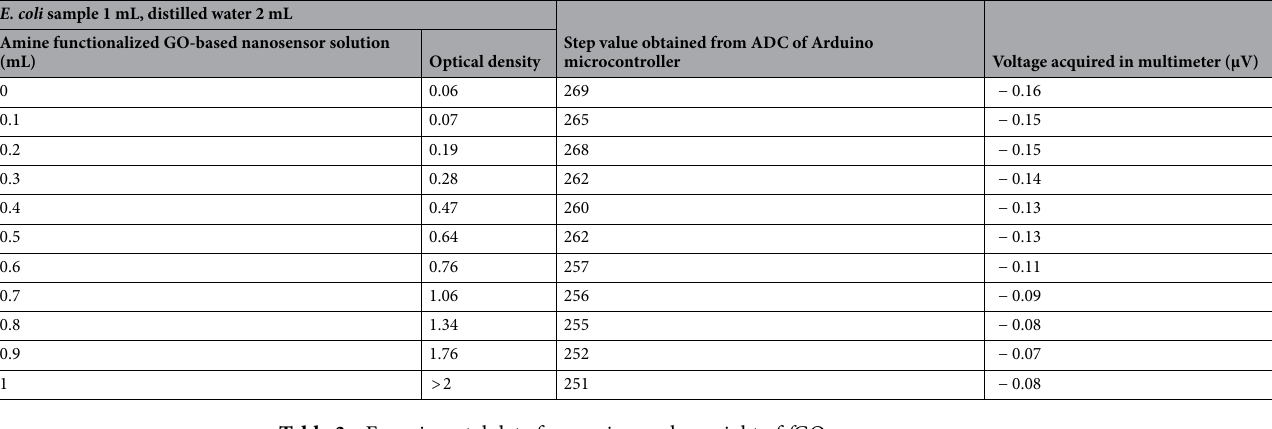
Table 3. Experimental data for varying molar weight of f GO.